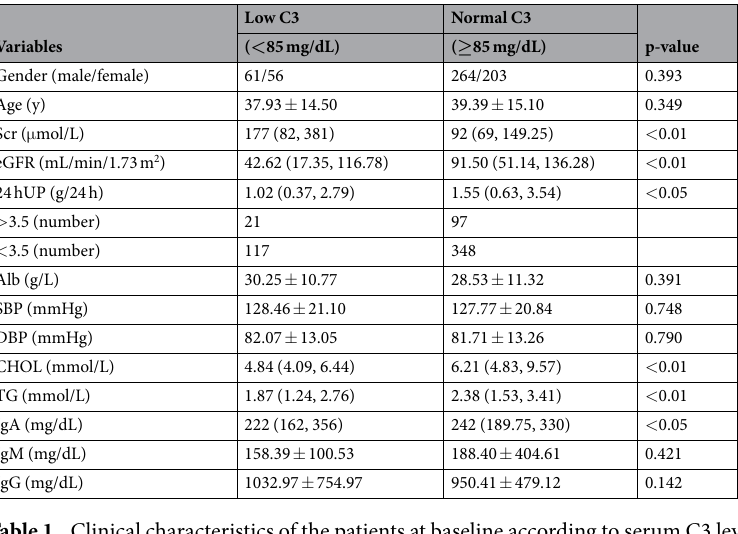
Table 1. Clinical characteristics of the patients at baseline according to serum C3 level. Scr: serum creatinine; 24 h UP: 24 h proteinuria; Alb: serum albumin; SBP: systolic blood pressure; DBP: diastolic blood pressure; CHOL: serum cholesterol; TG: serum triglyceride.